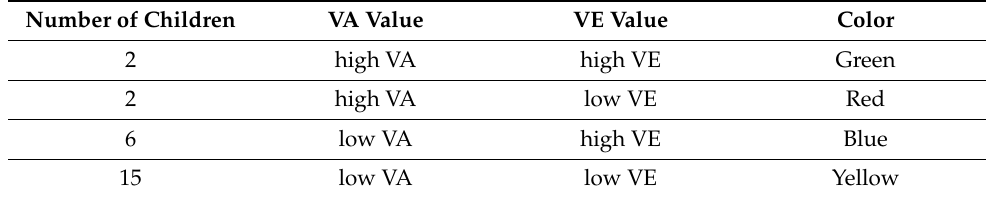
Table 1. Comparison of the spatial positions of children with the VA and VE distribution. Number of Children VA Value VE Value Color 2 high VA high VE Green 2 high VA low VE Red 6 low VA high VE Blue 15 low VA low VE